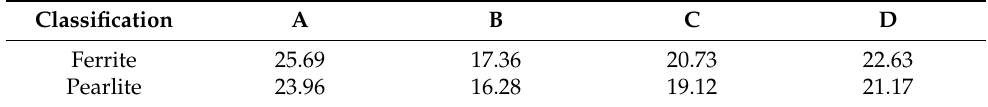
Table 2. Average grain size of ferrite and pearlite (μm).